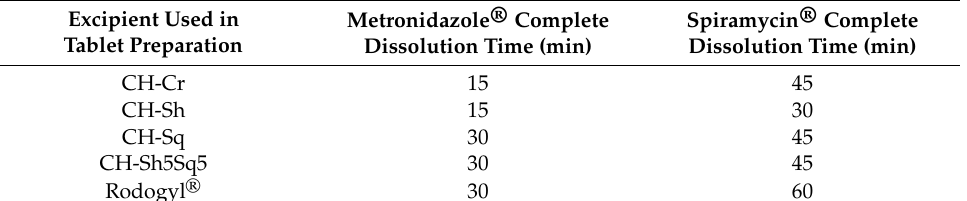
Table 8. Time for full drug release for metronidazole ® (125 mg) and spiramycin ® (0.75 M UI) tablets comprising compacted pure CHs from di ff erent sources, and CH mixture (CH-Sh5Sq5) compared to